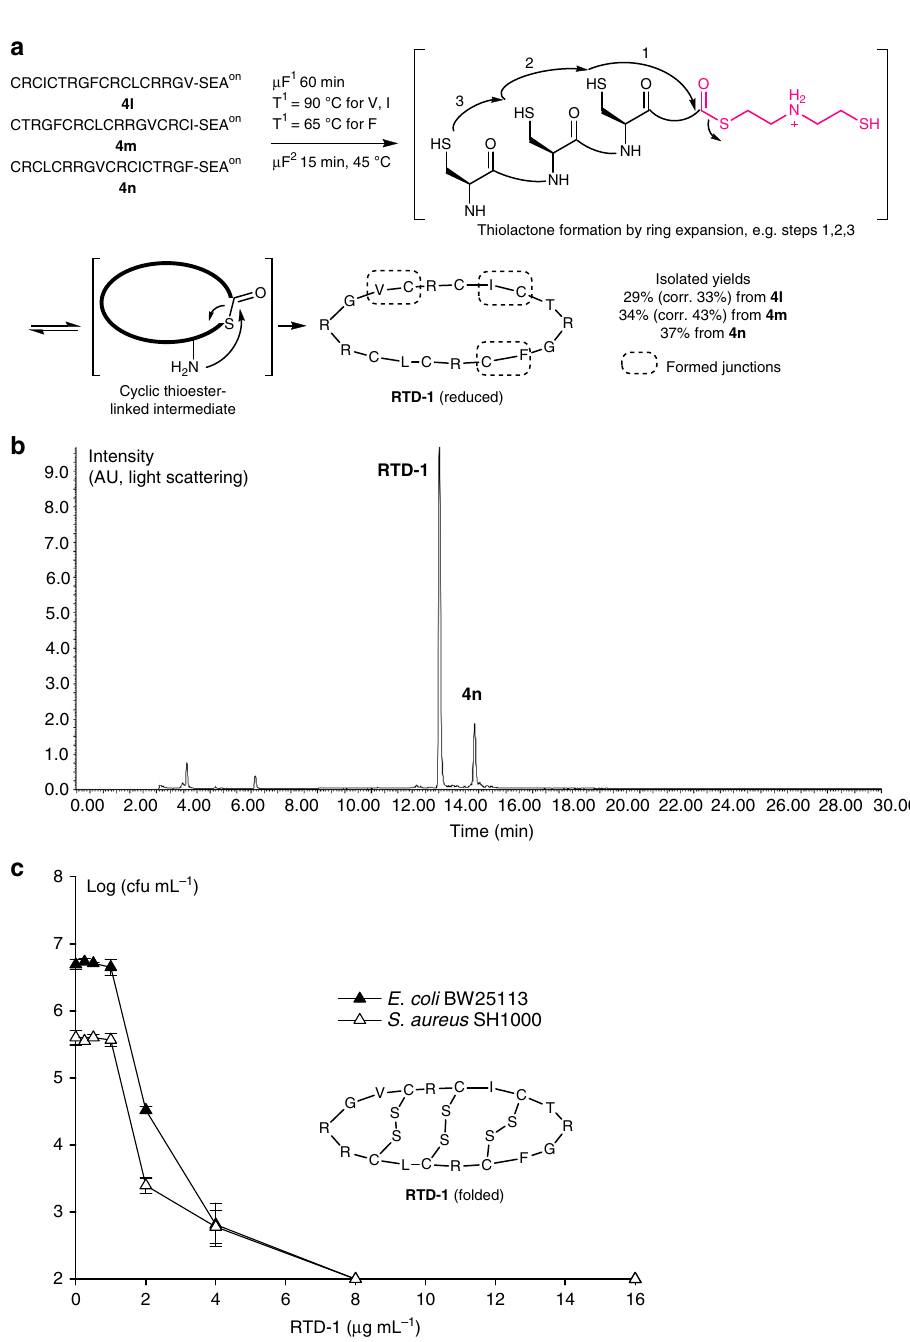
Fig. 5 Expanding the strategy to antimicrobial peptide RTD-1. a Three different junctions were assessed for the synthesis of RTD-1. The formation of intermediate thiolactone species imposed some adaptation to the optimal conditions de fi ned in Fig. 4a: the residence time and temperature in µ F 2 were increased from 4 to 15 min and from 37 to 45 °C. b Representative HPLC chromatogram for RTD-1 synthesis from peptide 4n . c Antibacterial activity of folded RTD-1 produced from 4m against E. coli BW 25113 ( fi lled triangles) and S. aureus SH 1000 strains (open triangles). The experiment was done in triplicate. The data correspond to the mean and standard deviation of the log10 transformed colony-forming units (cfu) per mL. The limit of detection is 100 cfu mL −